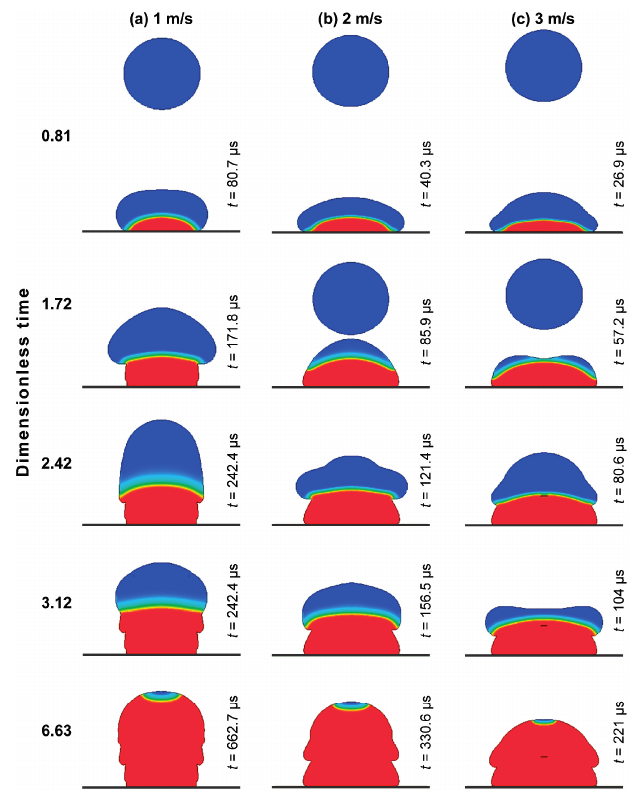
Figure 6. Impact of molten aluminum alloy droplet on a stainless steel surface at temperature 350 K with velocity ( a ) 1 m/s, ( b ) 2 m/s, and ( c ) 3 m/s; the distance between the two successive droplets is 220 μ m.